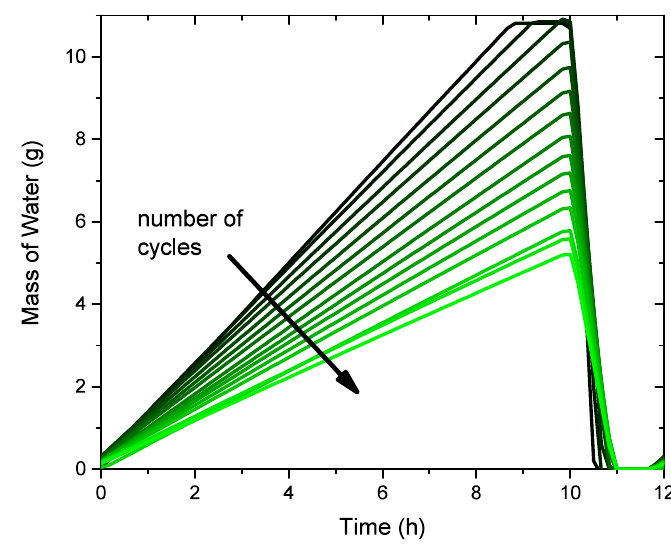
Figure 13. Mass of the liquid water in Vessel 2 at different cycles during the simulation.